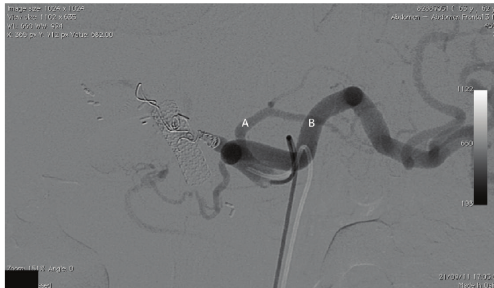
Figure 3: Arteriography of the celiac trunk after successful emboli- sation of the common hepatic artery and gastroduodenal artery. The left gastric artery (A) and splenic artery (B) remain